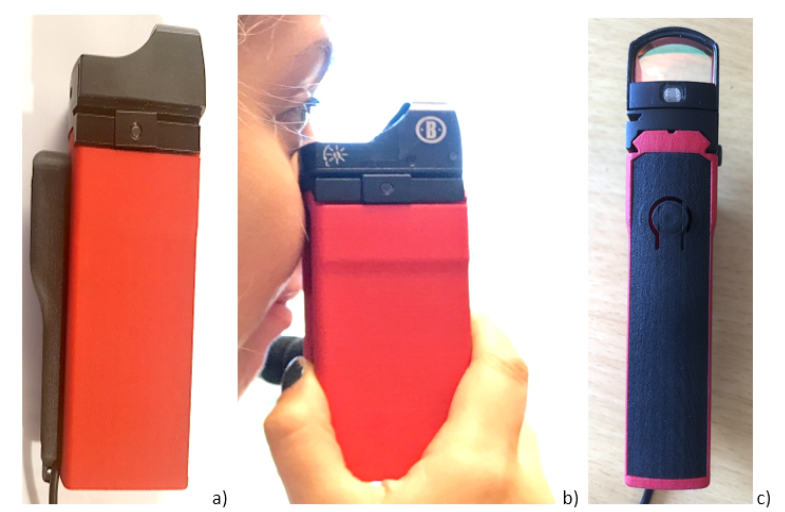
Figure 2. a) 2020 model Pi Geometer with a top-mounted red dot sight (covered) and an armoured USB connector cover; b) 2019 model held in vertical orientation, with sight cover removed; and c) front of the